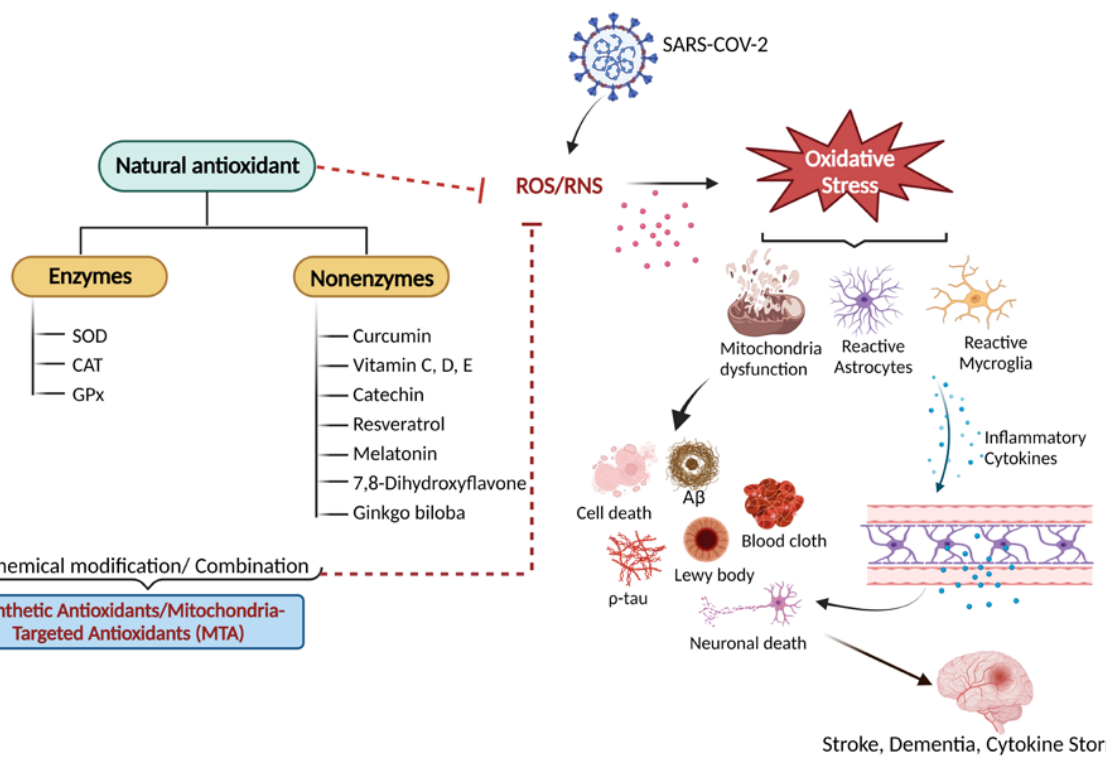
Figure 1. An overview of natural antioxidant systems and their role in scavenging ROS/RNS: Excessive ROS/RNS production triggers oxidative stress that causes mitochondrial dysfunction accompanied by the activation of astrocytes and microglia. Glial cell activation is associated with the release of inflammatory cytokines and chemokines, ultimately causing cellular apoptosis and neuronal